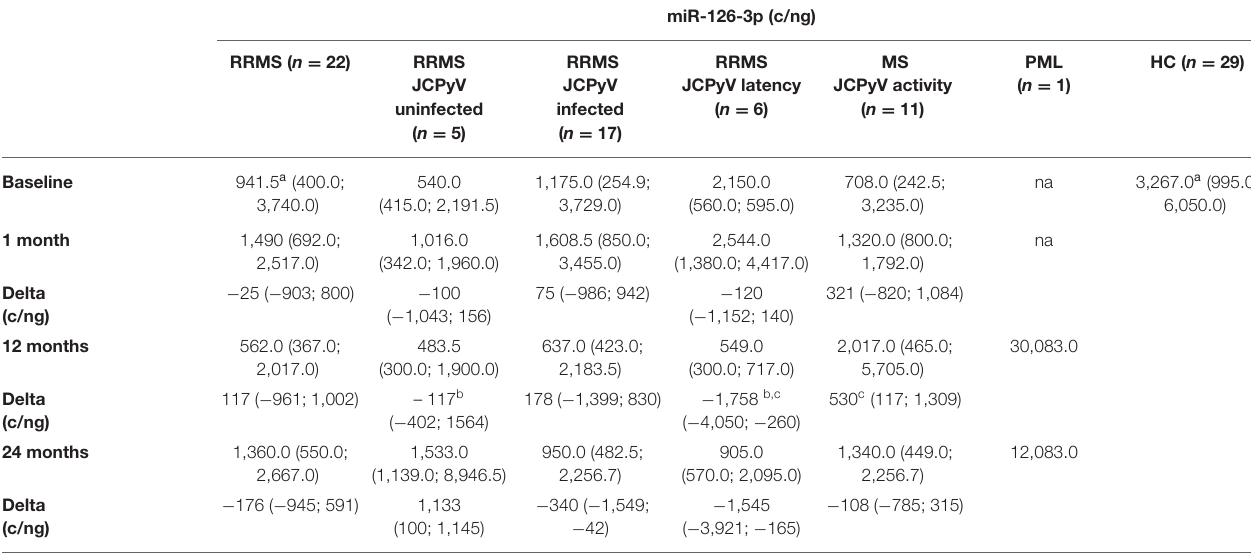
TABLE 2 | Serum miR-126-3p concentration (copies/ng) in RRMS, PML, and HC